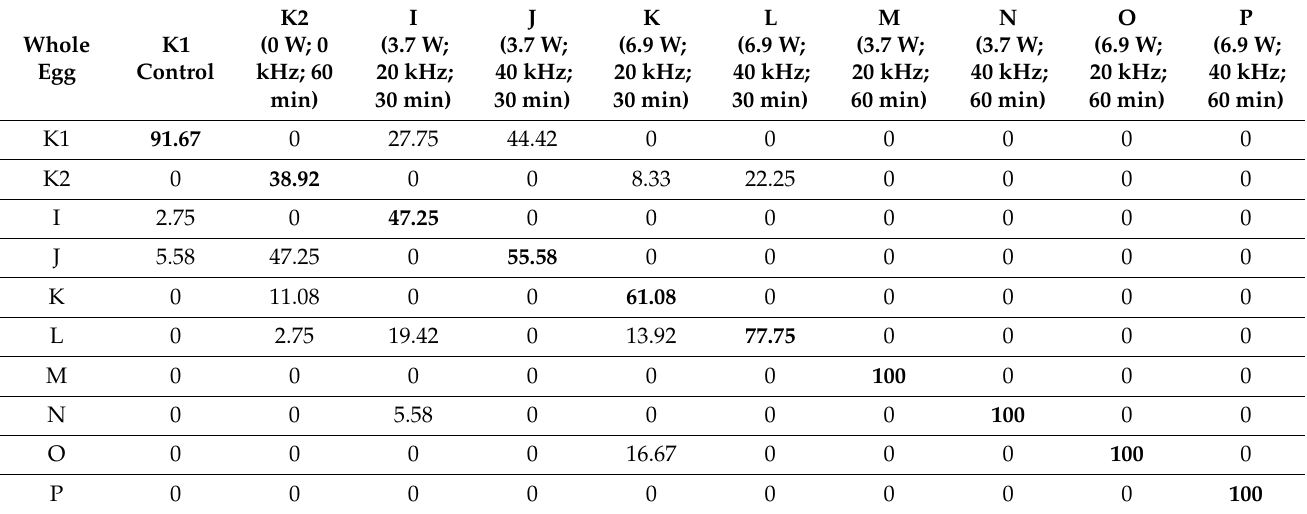
Table 6. Classification accuracy of linear discriminant analysis of whole egg samples,